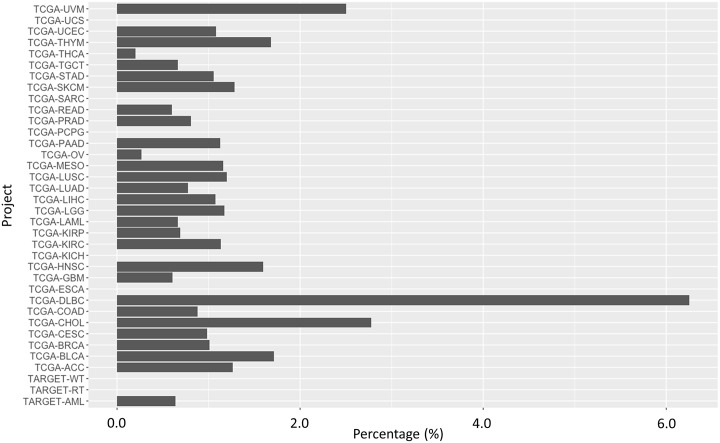
Percentage of cases that are ranked within top 100 in the predictive model over all cases in the TCGA project.The most statistically significant overrepresented cancer type is B-cell lymphoma (TCGA-DLBC).